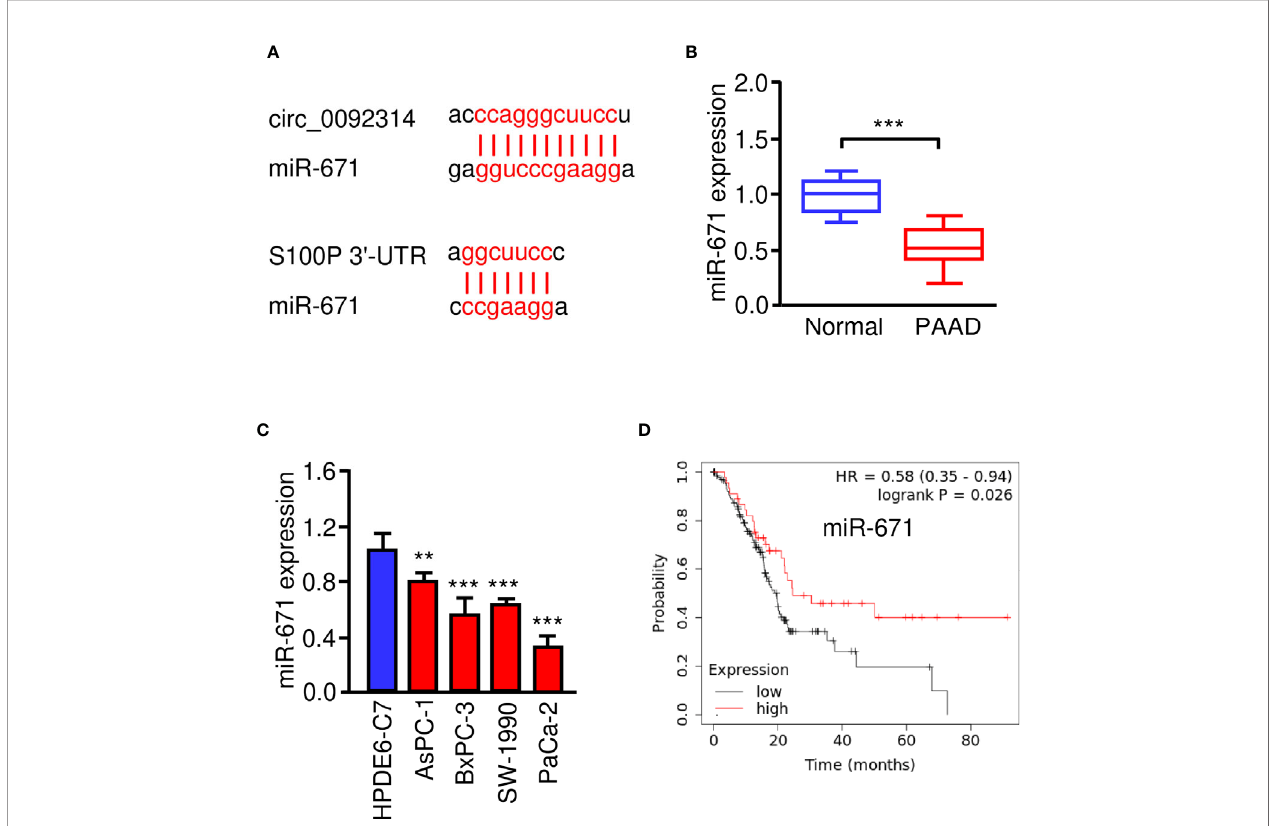
FIGURE 4 | MiR-671 is downregulated in PAAD tissues and positively correlates with patient prognosis. (A) The predicted binding site of miR-671 within circ_0092314 and the S100P 3 ′ -UTR sequence were shown. (B) The expression of miR-671 in PAAD tissues and adjacent normal tissues. (C) qRT-PCR analysis of miR-671 expression in four PAAD cell lines and normal pancreatic cells. (D) Kaplan-Meier curves for the overall survival of PAAD patients with high or low levels of miR-671 (KM Plotter database). ** P <0.01, *** P